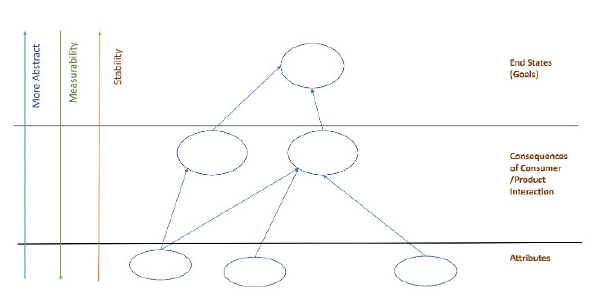
Figure 2 Customer Value Hierarchy – Model